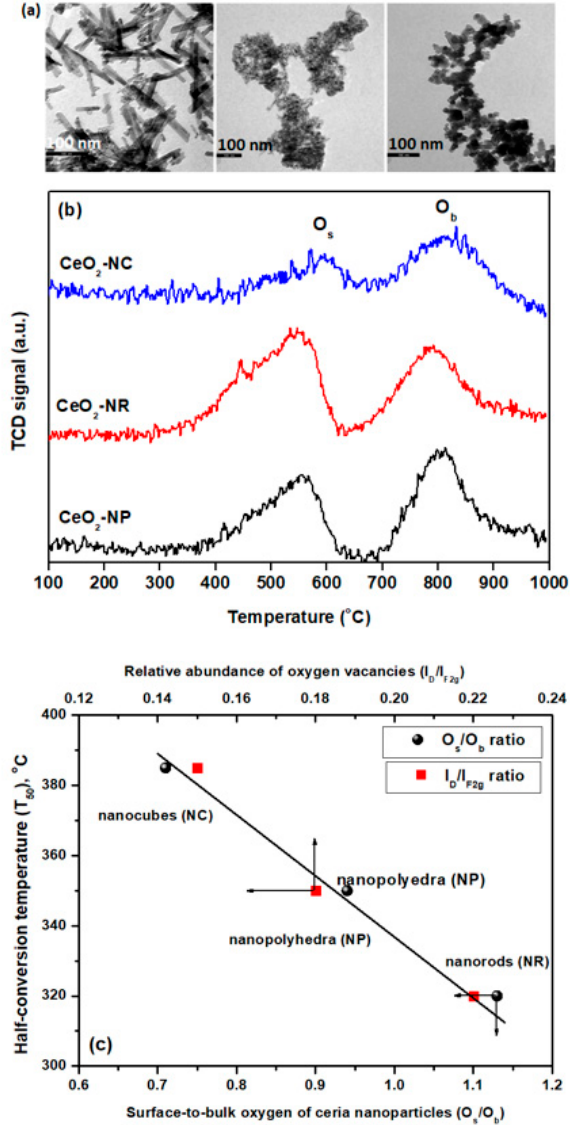
Figure 7. ( a ) TEM images and ( b ) H 2 -TPR profiles for ceria nanoparticles of different morphology, i.e.,